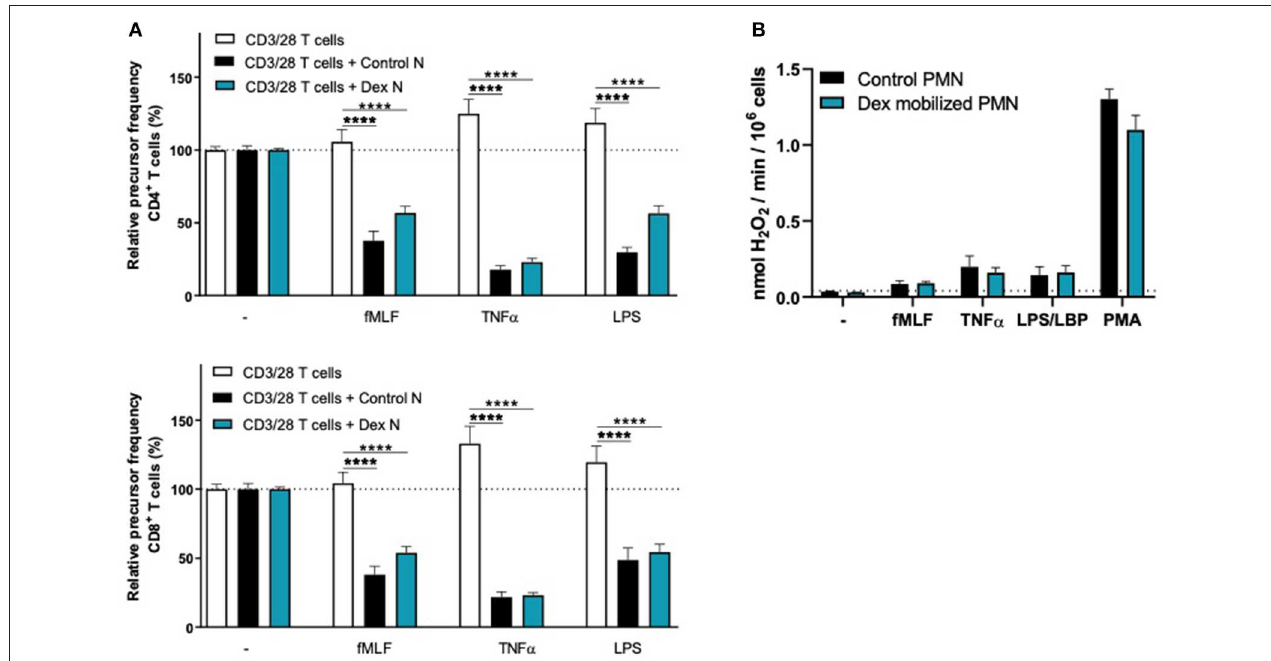
FIGURE 5 | Dex-mobilized neutrophils can suppress the T cell proliferation and have normal respiratory burst. (A) Purified CFSE-labeled T cells from healthy donors ( n = 4) were cultured in absence (white bars) or presence of mature neutrophils from control donors (black bars, n = 4), or Dex-mobilized neutrophils (blue bars, n = 3). T cells were stimulated with anti-CD3 and anti-CD28 antibodies. Neutrophils were kept unstimulated or activated with the indicated stimuli. After 4 or 5 days, cells were harvested and analyzed by flow cytometry for CFSE dilution among CD4 + (upper graph) and CD8 + (lower graph) T cells. Error bars indicate SEM; the statistical analysis one-way ANOVA was used. (B) Dex-mobilized neutrophils or control neutrophils were stimulated with the indicated stimuli and production of H 2 O 2 was determined by measuring Amplex Red conversion into fluorescent Resorufin ( n = 3–6). Error bars indicate SEM; the statistical analysis unpaired two-tailed t- test was used. **** p <